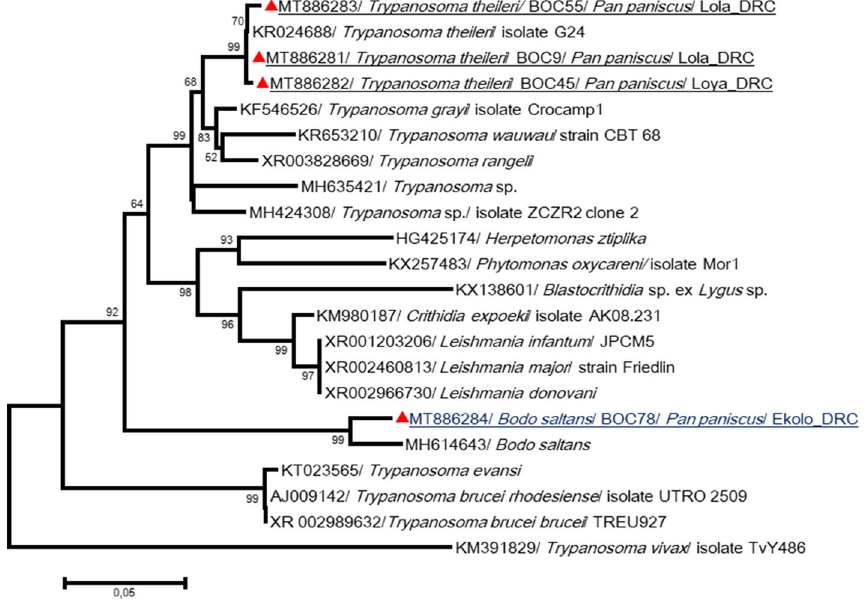
Figure 7. Phylogenetic analysis of Kinetoplastida spp. detected in this study. The evolutionary history, based on 18S rRNA gene, was inferred using the Neighbor-Joining method. The obtained sequences here were compared to sequences of Kinetoplastida spp. available in GenBank. Sequences are identified as follows: accession number/species/strain/host/country. Sequences in Lola were almost identical and presented > 99% identity with Trypanosoma theleiri (KR024688), known as pathogen for ruminants. Whereas, in Ekolo, one other sequence was closely identical to Bodo saltans (MH614643) , a free living nonpathogenic kinetoplastid. The